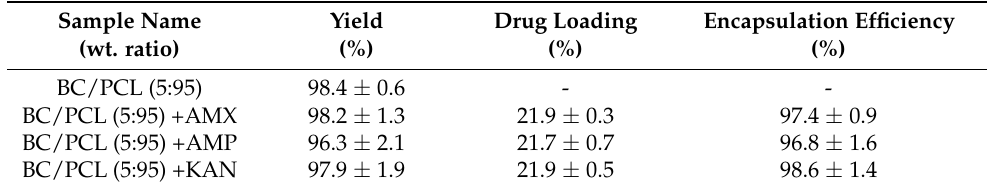
Table 3. Yield percentage, drug loading, and encapsulation efficiency of the patches. (Mean ± SD, n =